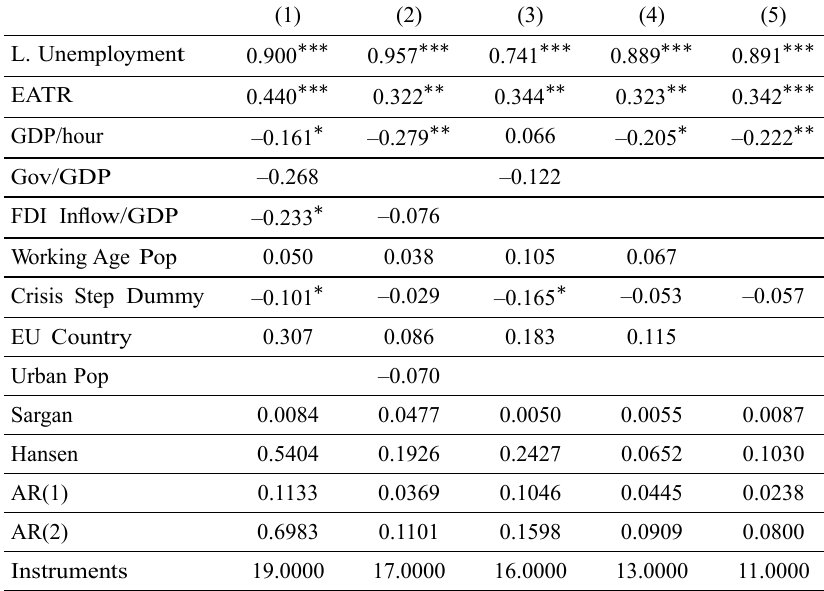
Table 5. Estimation results with differing